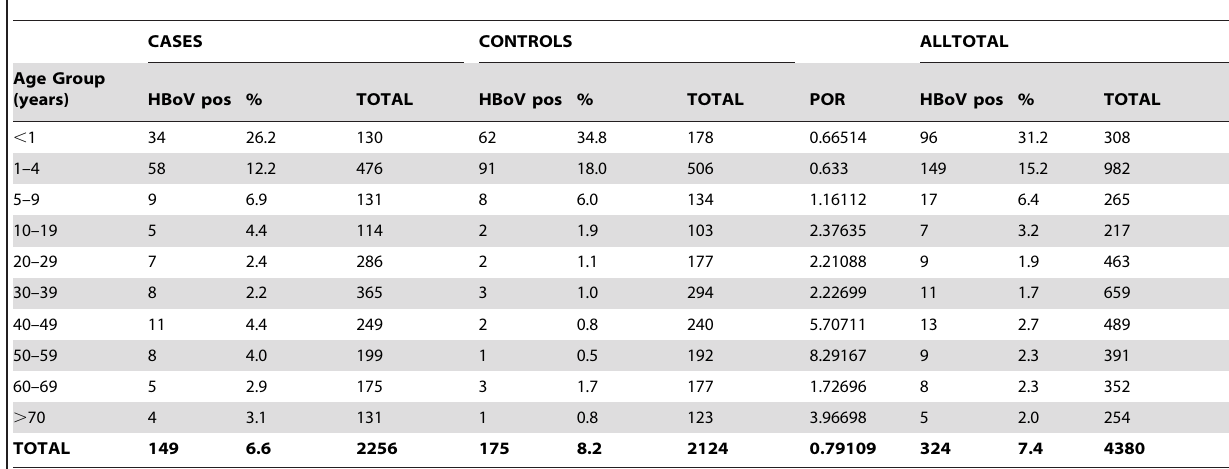
Table 2. Age distribution of HBoV positive samples in cases and controls of IID.